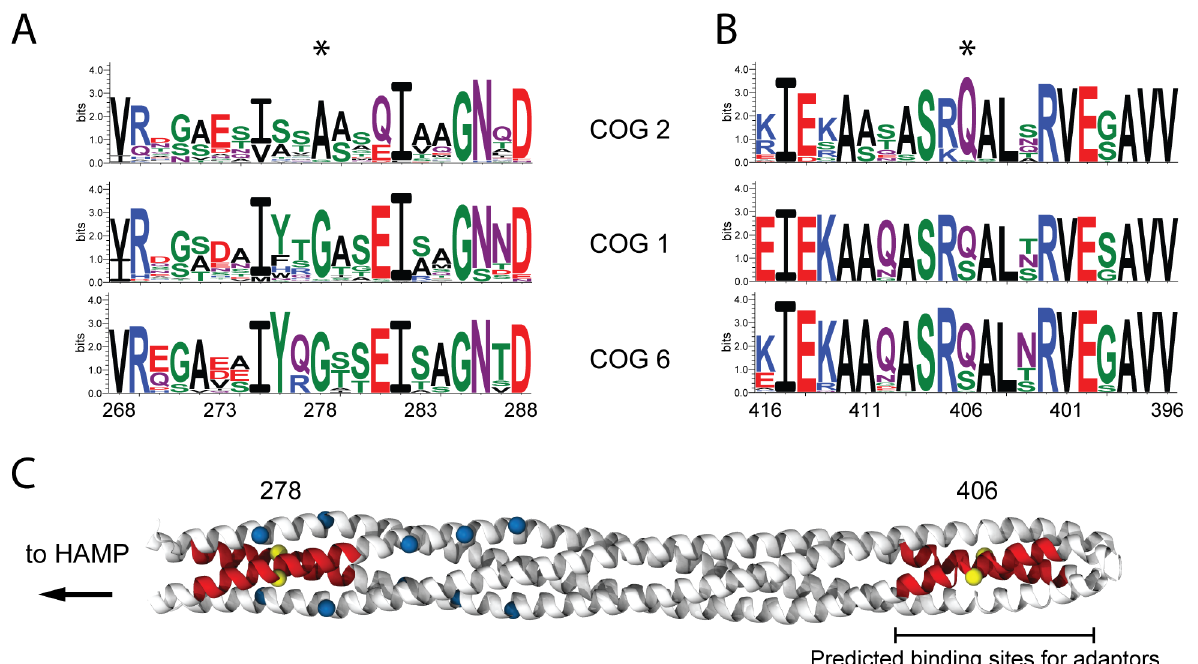
Fig 5. Changes in conservation patterns in chemoreceptors. Comparison of the sequence logo from sequences in COG1, COG2 and COG6 of the 20 amino-acid region around the Gly278 (A) and Ser406 (B), both marked with a star. The sequence is inverted in the B panel (right to left) to depict the difference in helix where the two positions are found. Gly278 is found in the descending helix and S406 is found in the ascending helix of the receptor. C) Cartoon representation based on the crystal structure (PDB code: 1QU7) [56] of the chemoreceptor signaling domain (white ribbons) and the methylation sites (blue spheres) with mapping of the 10 amino-acid region (red ribbons) around the two positions (yellow spheres) with significantly different pattern in sequences from COG2 compared to sequences from COG1 and COG6.